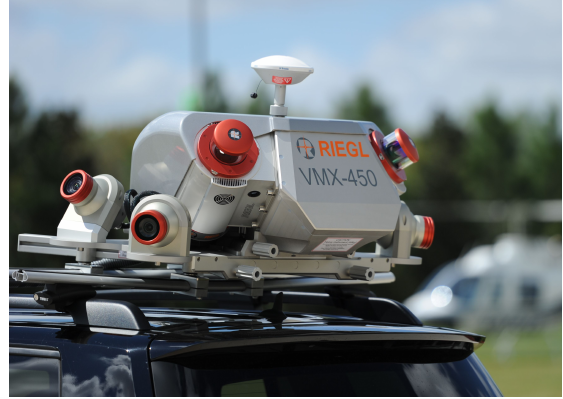
Figure 1: RIEGL MLS system VMX-450.